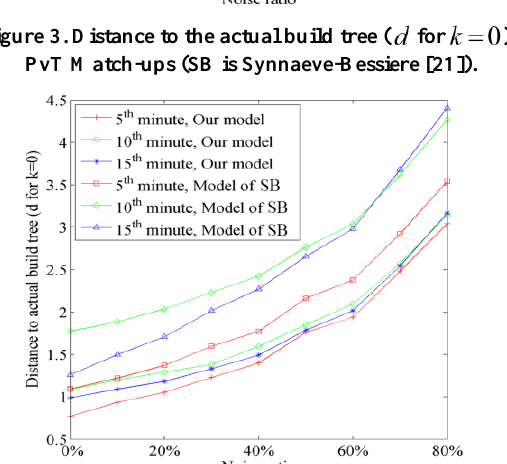
Figure 4. Distance to the actual build tree ( for ) , PvZ Match-ups (SB is Synnaeve-Bessiere [21]).